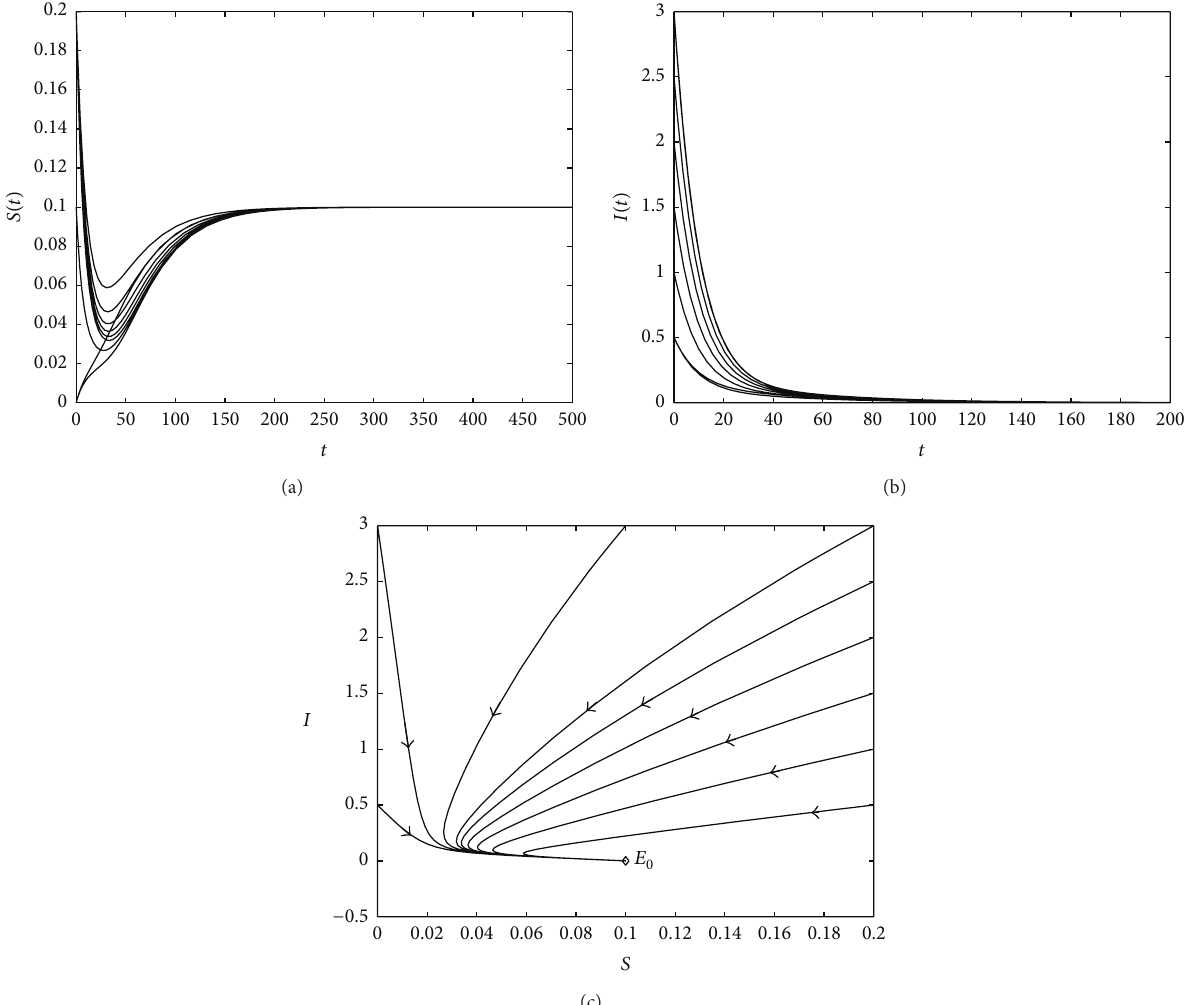
Figure 2: 𝜏 > 0 , 𝑅 0 < 1 . The solutions of system (6) tends to the disease-free equilibrium 𝐸 0 = (0.1, 0) .